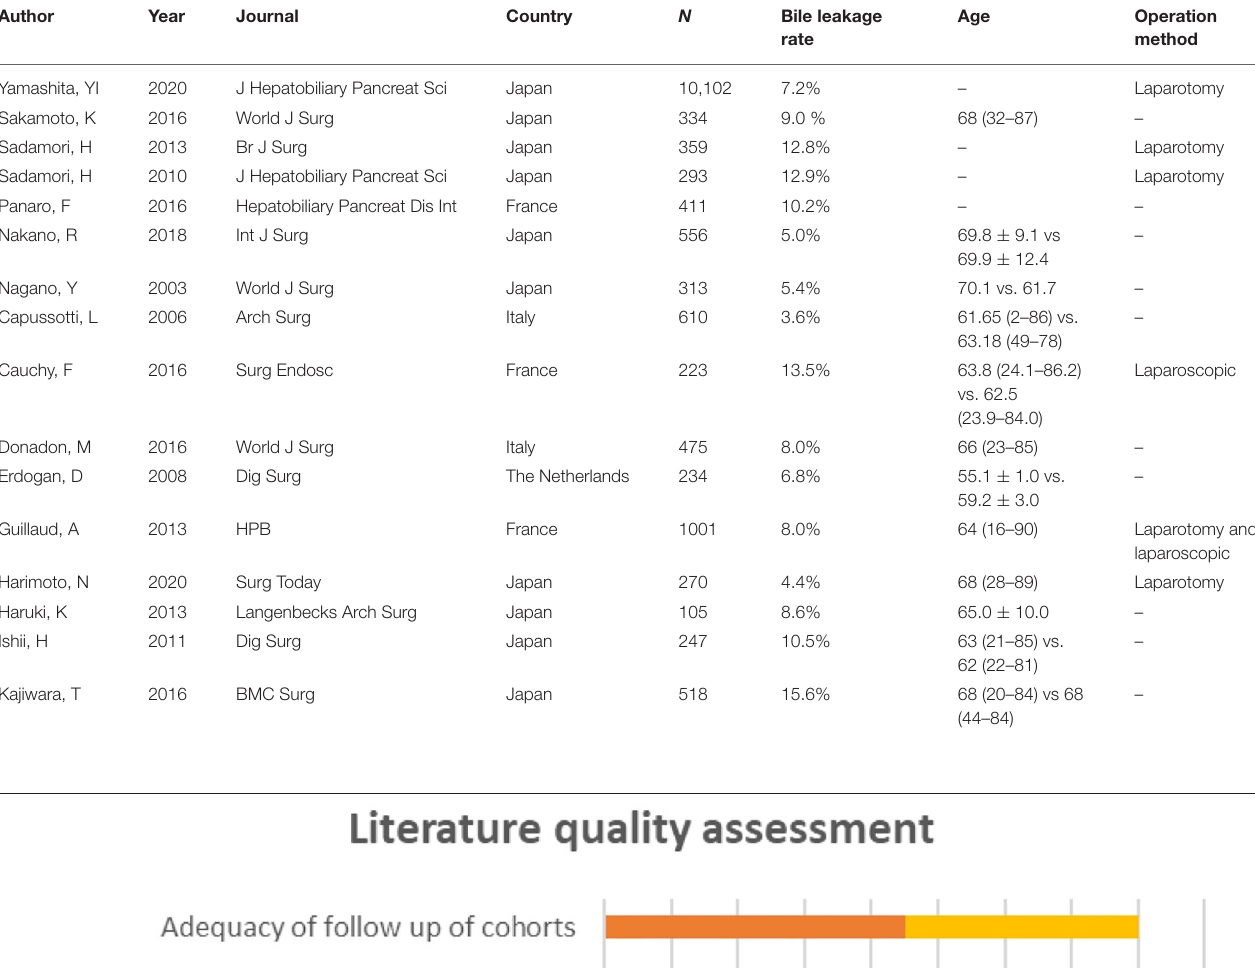
TABLE 1 | Characteristics of studies included in meta-analysis.